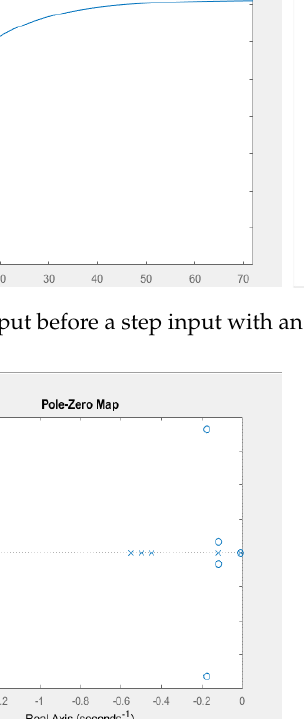
Figure 36. Output before a step input with an amplitude of 72, in Stella.